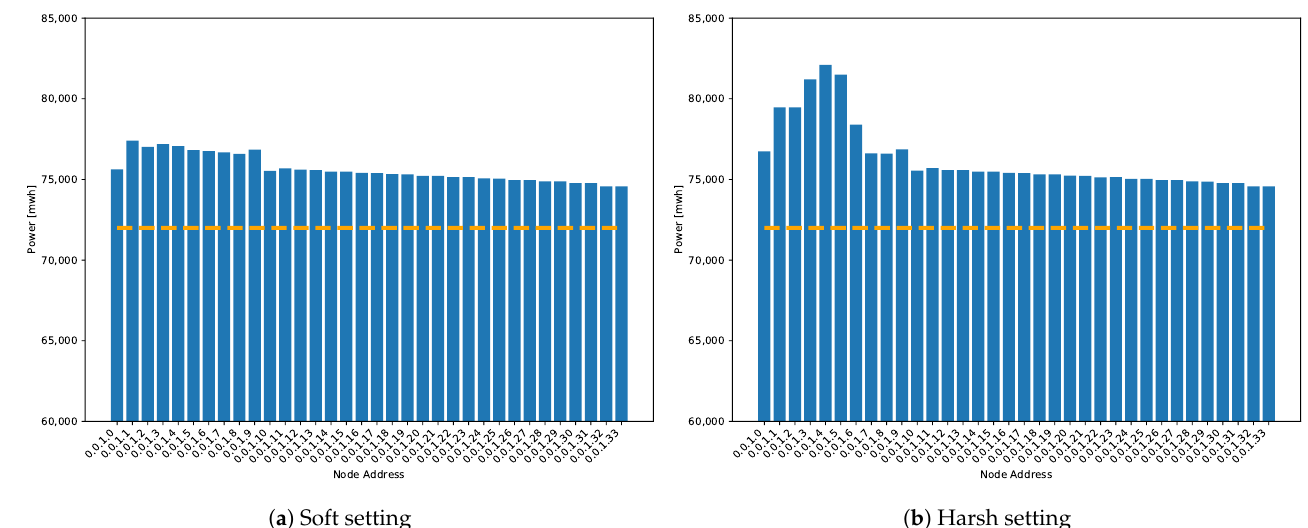
Figure 15. Power consumption per node. The dashed line marks the base consumption related to the idle state that each node consumes during the simulation time independently of its activity due to the application of this experiment. For clarity, the minimum value shown is 60,000